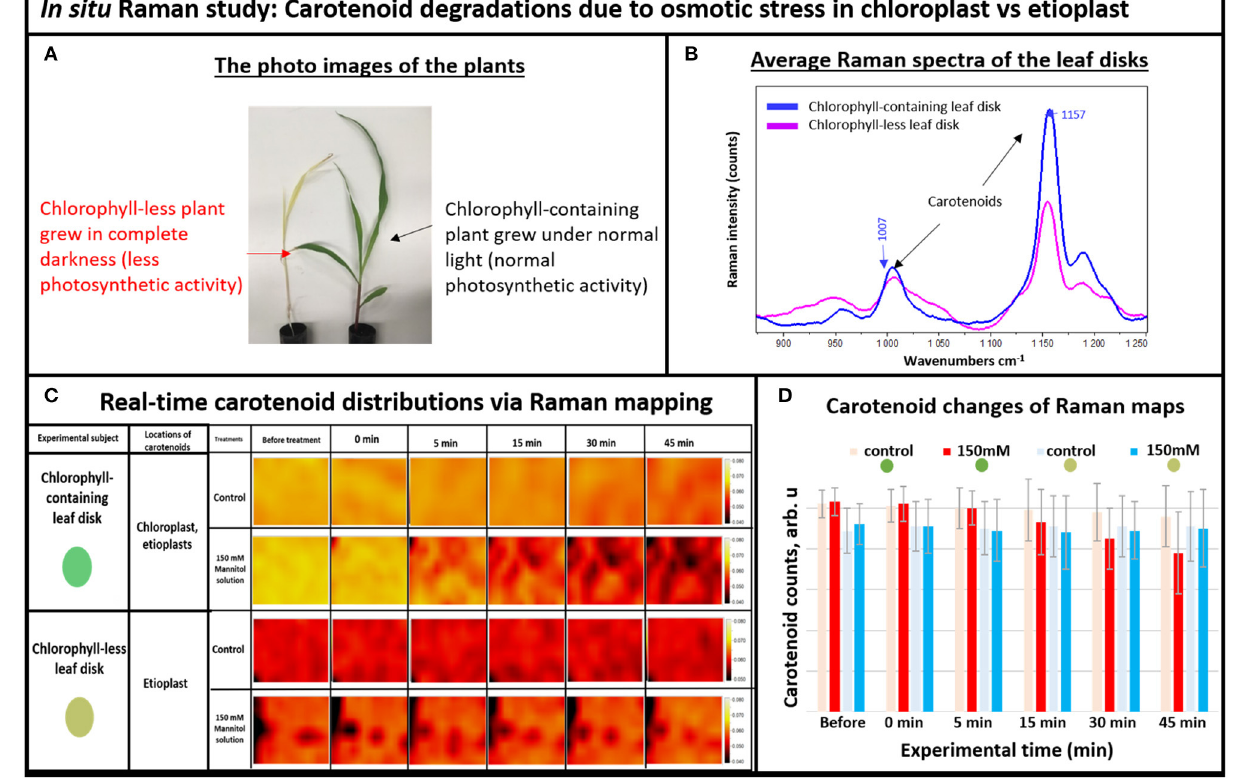
FIGURE 2 | (A) The photo images of the experimental plants: chlorophyll-containing (green) vs. chlorophyll-less (white), (B) Average Raman spectra of the chlorophyll-containing and chlorophyll-less leaf disks, (C) Real-time carotenoid distribution changes due to the 150mM mannitol solution vs. pure deionized water, green and white leaf disks (areas of 170 × 140 µ m): before treatments and 0, 5, 15, 30, and 45min after the treatments. (D) Histogram of carotenoid changes of Raman maps. Each bar represents mean + SD ( n = 80 × 3 ×